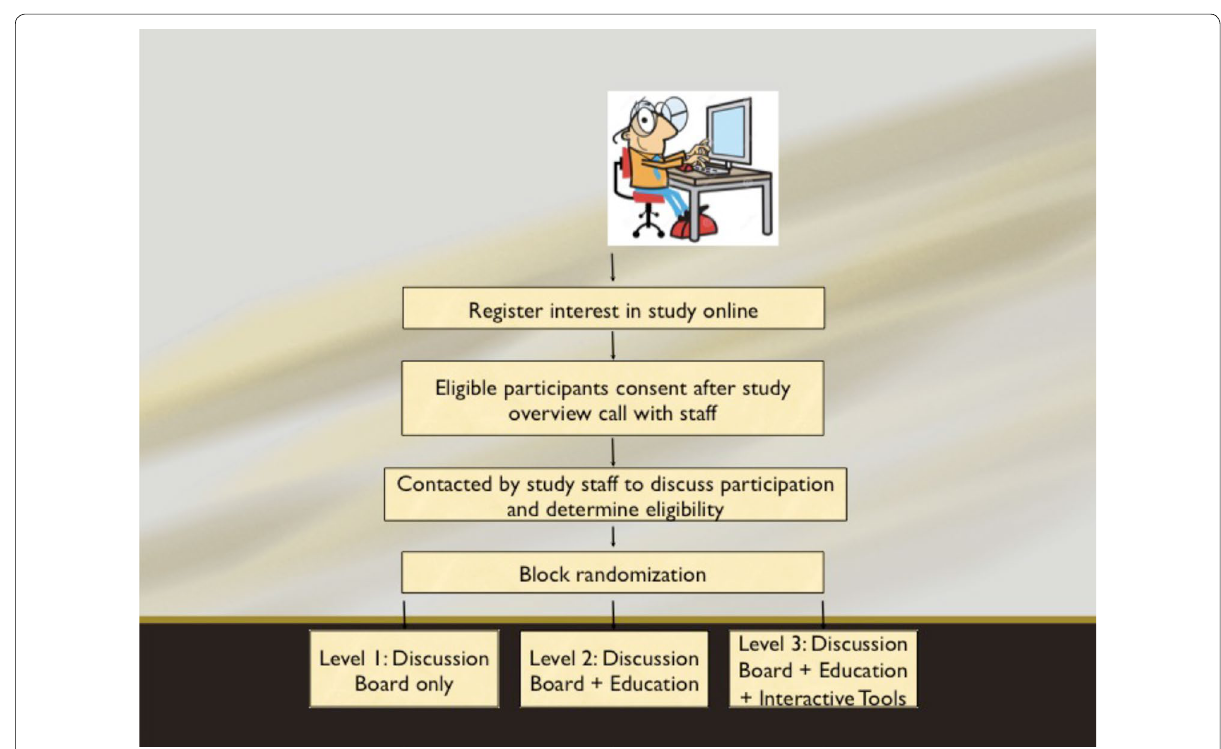
Fig. 1 MoodSwings 2.0 study design. Figure shows flow for study procedures from first contact through intervention and